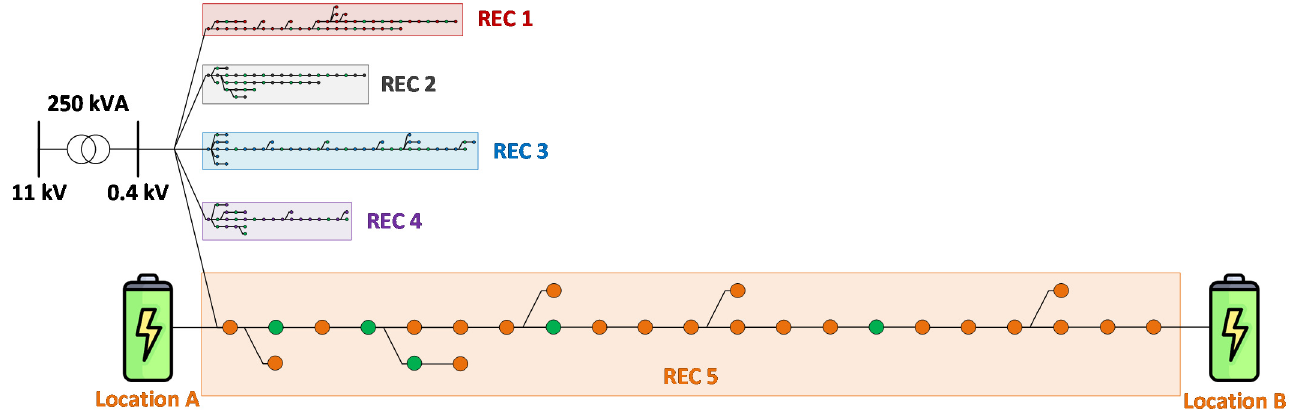
Figure 6. Possible locations for Centralized Community Storage Systems for EC5. Location A is the start of the REC. Location B is at the end of the REC.